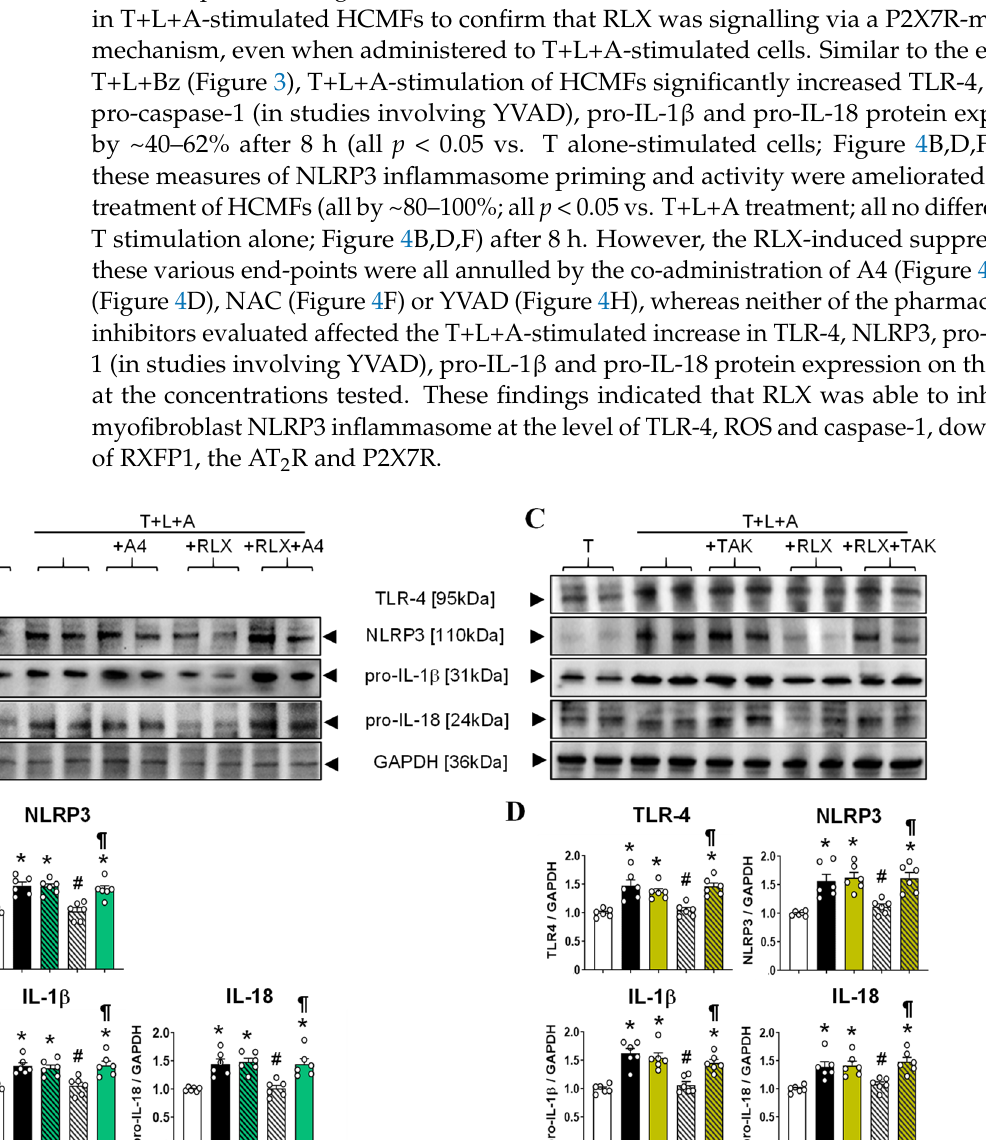
Figure 4. The effects of RLX ± the P2X7R inhibitor (A4), TLR-4 inhibitor (TAK), ROS inhibitor (NAC) and caspase-1 inhibitor (YVAD) on the T+L+A-stimulated increase in myofibroblast NLRP3 inflam- masome measures. ( A , C , E , G ) Representative Western blots of TLR-4, NLRP3 (or pro-caspase-1 for the studies involving YVAD), pro-IL- β and pro-IL-8 expression from HCMFs treated with TGF- β 1 (T), T+L+A, T+L+A+A4, T+L+A+RLX or T+L+A+RLX +A4 ( A ); T, T+L+A, T+L+A+TAK, T+L+A+RLX or T+L+A+RLX +TAK ( C ); T, T+L+A, T+L+A+NAC, T+L+A+RLX or T+L+A+RLX+NAC ( E ); or T,